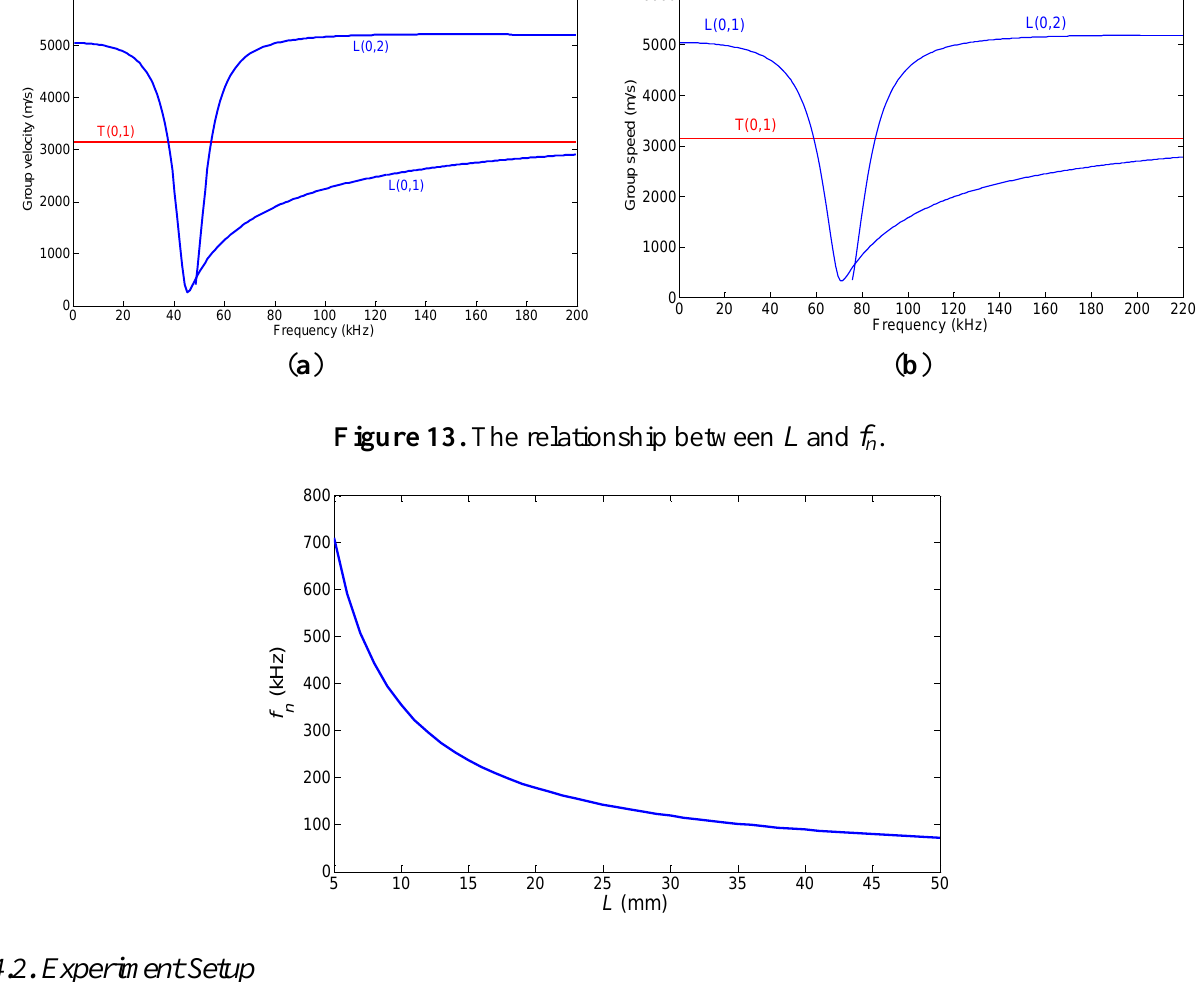
Figure 12. The group velocity dispersion curve of both pipes. ( a ) pipe A. ( b ) pipe B.